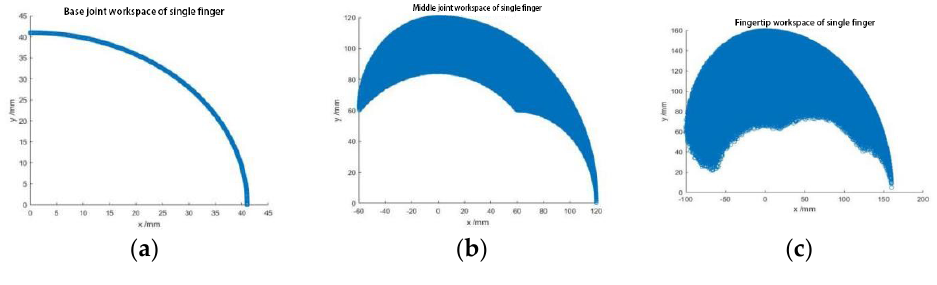
Figure 17. Single- fi nger model